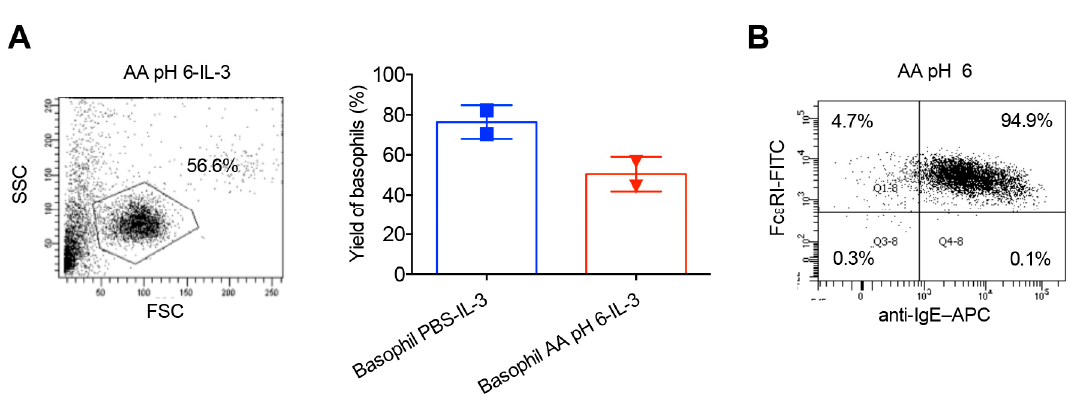
Figure 5. Acetic acid buffer pH 6 improves the viability of basophils but is ineffective to strip off IgE from the basophils. Basophils were incubated on ice for 5 min with ice-cold acetic acid buffer pH 6 (AA pH 6). Cells were then washed and cultured in serum-free X-VIVO 15 medium (0.1 × 10 6 cells/well per 200 µL) in 96-well U-bottomed plate along with IL-3 (100 ng/0.5 million cells) for 24 h. ( A ) The forward and side scatter plot of AA pH 6-treated basophils following 24-h culture in IL-3 (left panel) and the yield of basophils (mean ± SD, n = 2 donors) (right panel). The values were calculated based on the percentage of cells in the P1 gate of forward and side scatter plot. ( B ) Efficacy of stripping of basophil surface-bound IgE by AA pH 6 as analyzed by surface staining of IgE and analyses by flow cytometry .